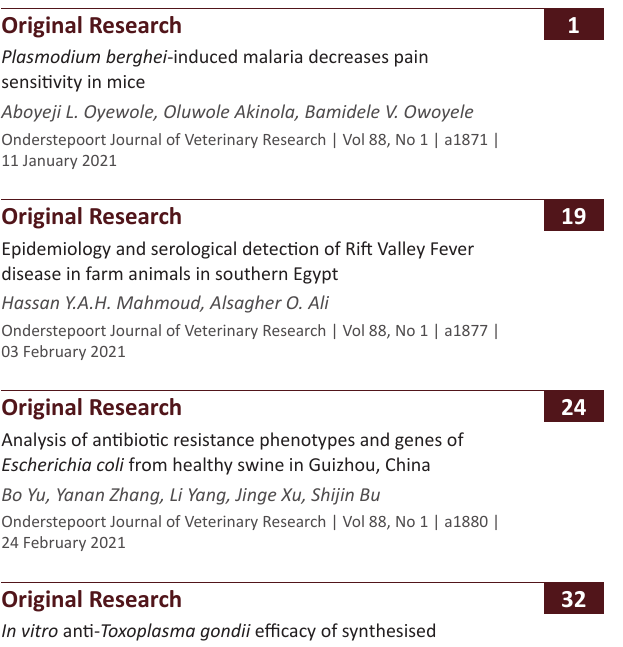
small mammals in South